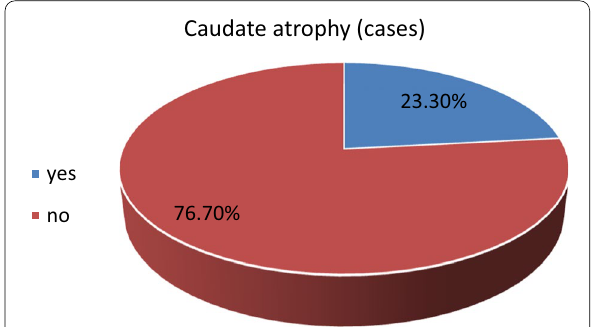
Fig. 5 Diagrammatic representation of percent of patients with caudate atrophy